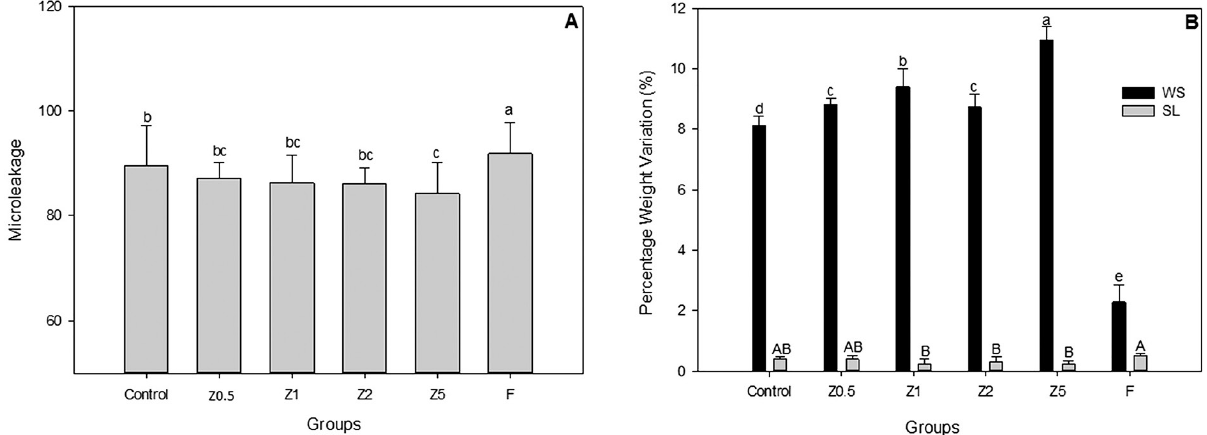
Figure 1- (A) Microleakage means of experimental TFMs with ZM and the commercial reference; (B) Water sorption and Solubility expressed in